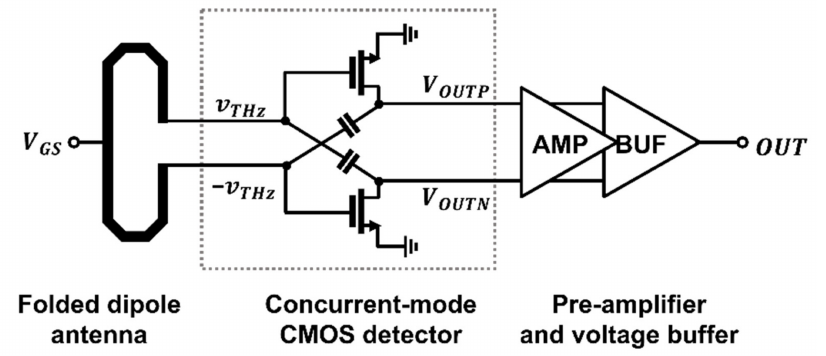
Figure 5. CMOS detector IC comprising a 200-GHz folded dipole antenna, the proposed detector, a differential-to-single-ended preamplifier, and a voltage